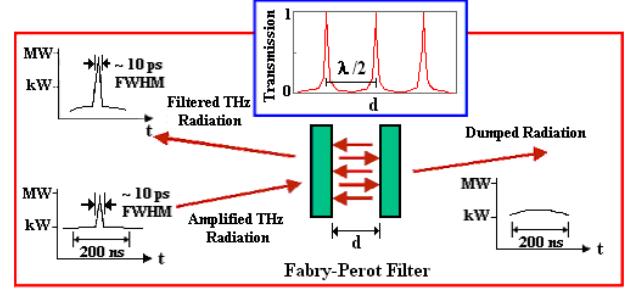
FIG. 9. (Color) Scheme for improving the THz contrast by using a Fabry-Perot filter.